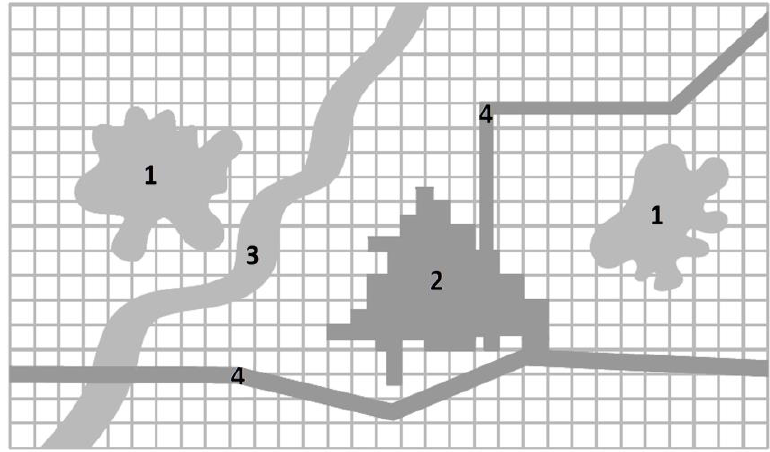
Figure 3. Environmental mosaic scheme composed of different patches and corridors. 1. Natural patch; 2. Anthropic patch; 3. Natural corridor; 4. Anthropic corridor. (Source: [22]).